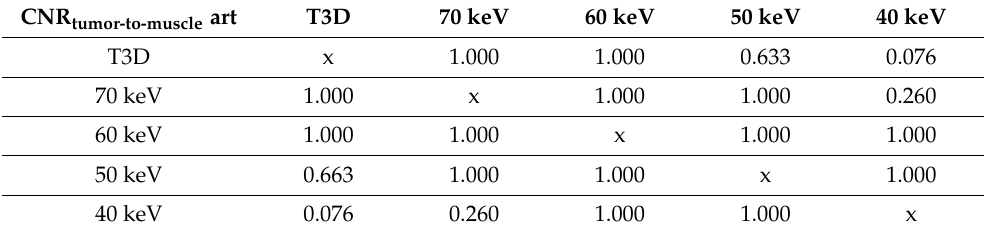
Table 13. Comparison of arterial CNR tumor-to-muscle between T3D and low keV images. CNR tumor-to-muscle art T3D 70